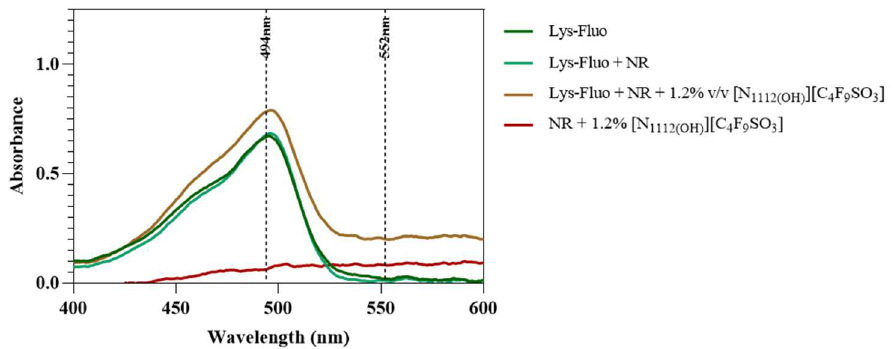
Figure 16. Absorbance spectra of Lys-Fluo + NR samples in the presence of 0 and 1.2% v / v [N 1112(OH) ][C 4 F 9 SO 3 ]. Vertical lines mark Fluo and NR λ exc (494 and 554 nm, respectively).